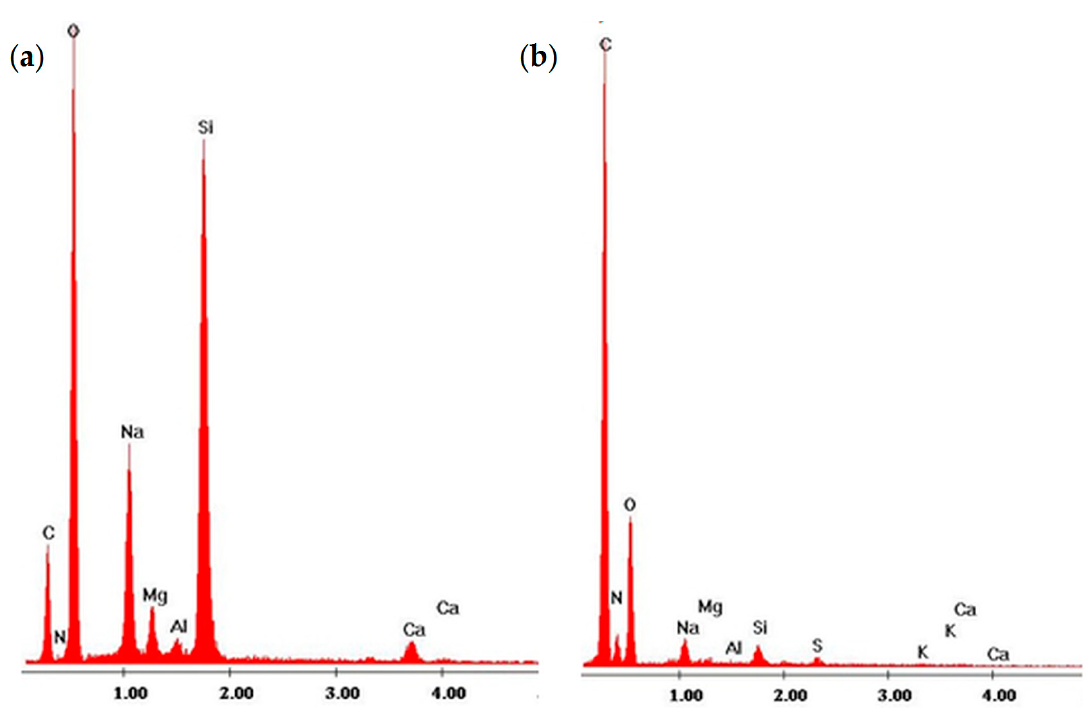
Figure 10. The elemental composition of glass support surface ( a ) before plasma and ( b ) after plasma deposition of laccase.